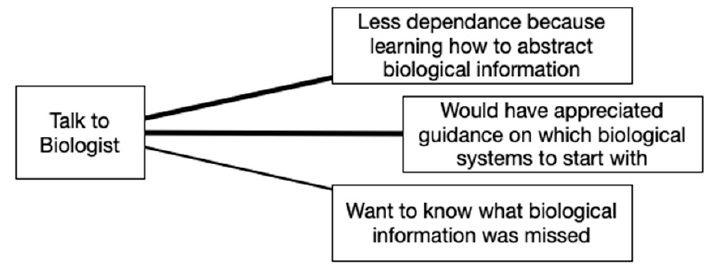
Figure 7. Talk to biologist discussion